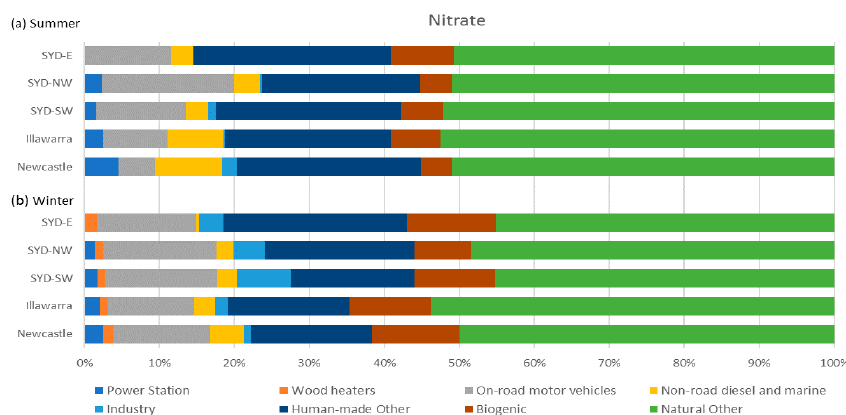
Figure 7. Regional average major source groups contribution (%) to particulate nitrate mass in the Sydney East (SYD-E), Sydney Northwest (SYD-NW), Sydney Southwest (SYD-SW), Illawarra and Newcastle regions in ( a ) summer and ( b ) winter of 2008.